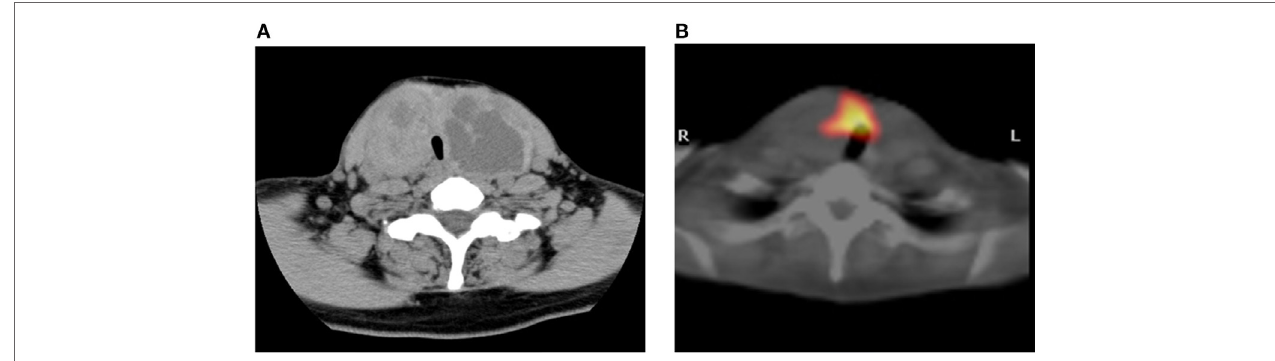
FIGURe 1 | Imaging study . CT scan showing multinodular enlargement of the thyroid gland (a) . The corresponding region of radioiodine uptake represents cold nodules in this SPECT/CT fusion image (B)